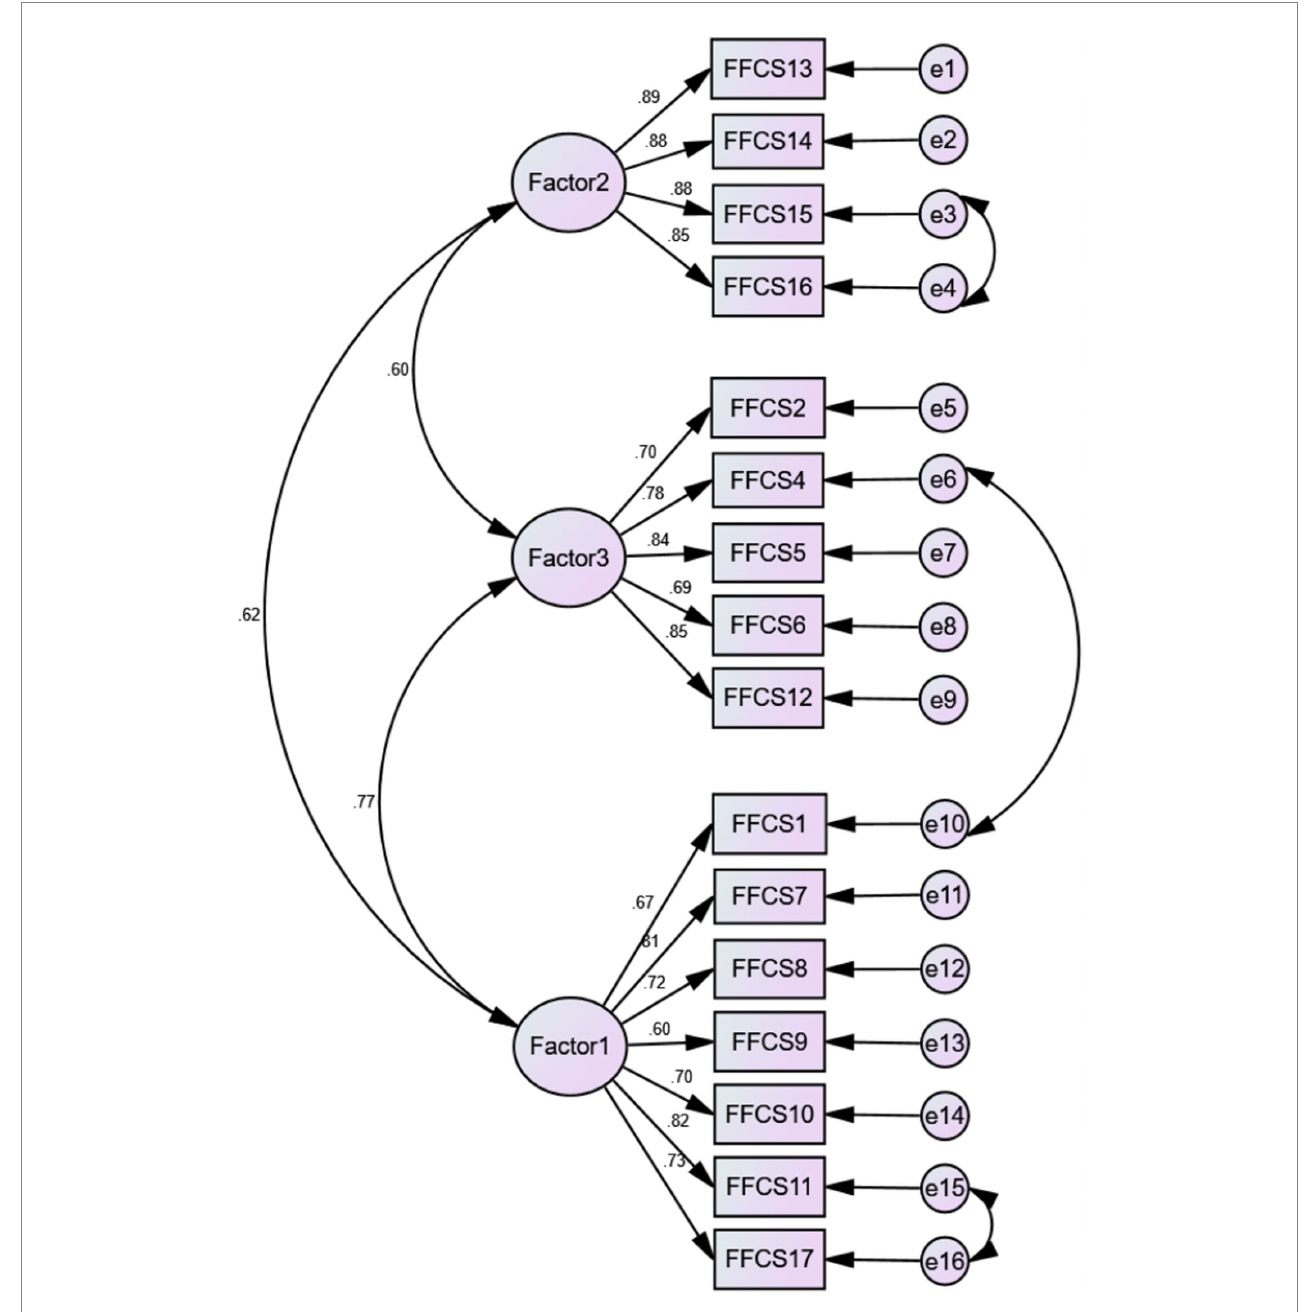
FIGURE 2 Modified confirmatory factor analysis of the three factor 16-item model.